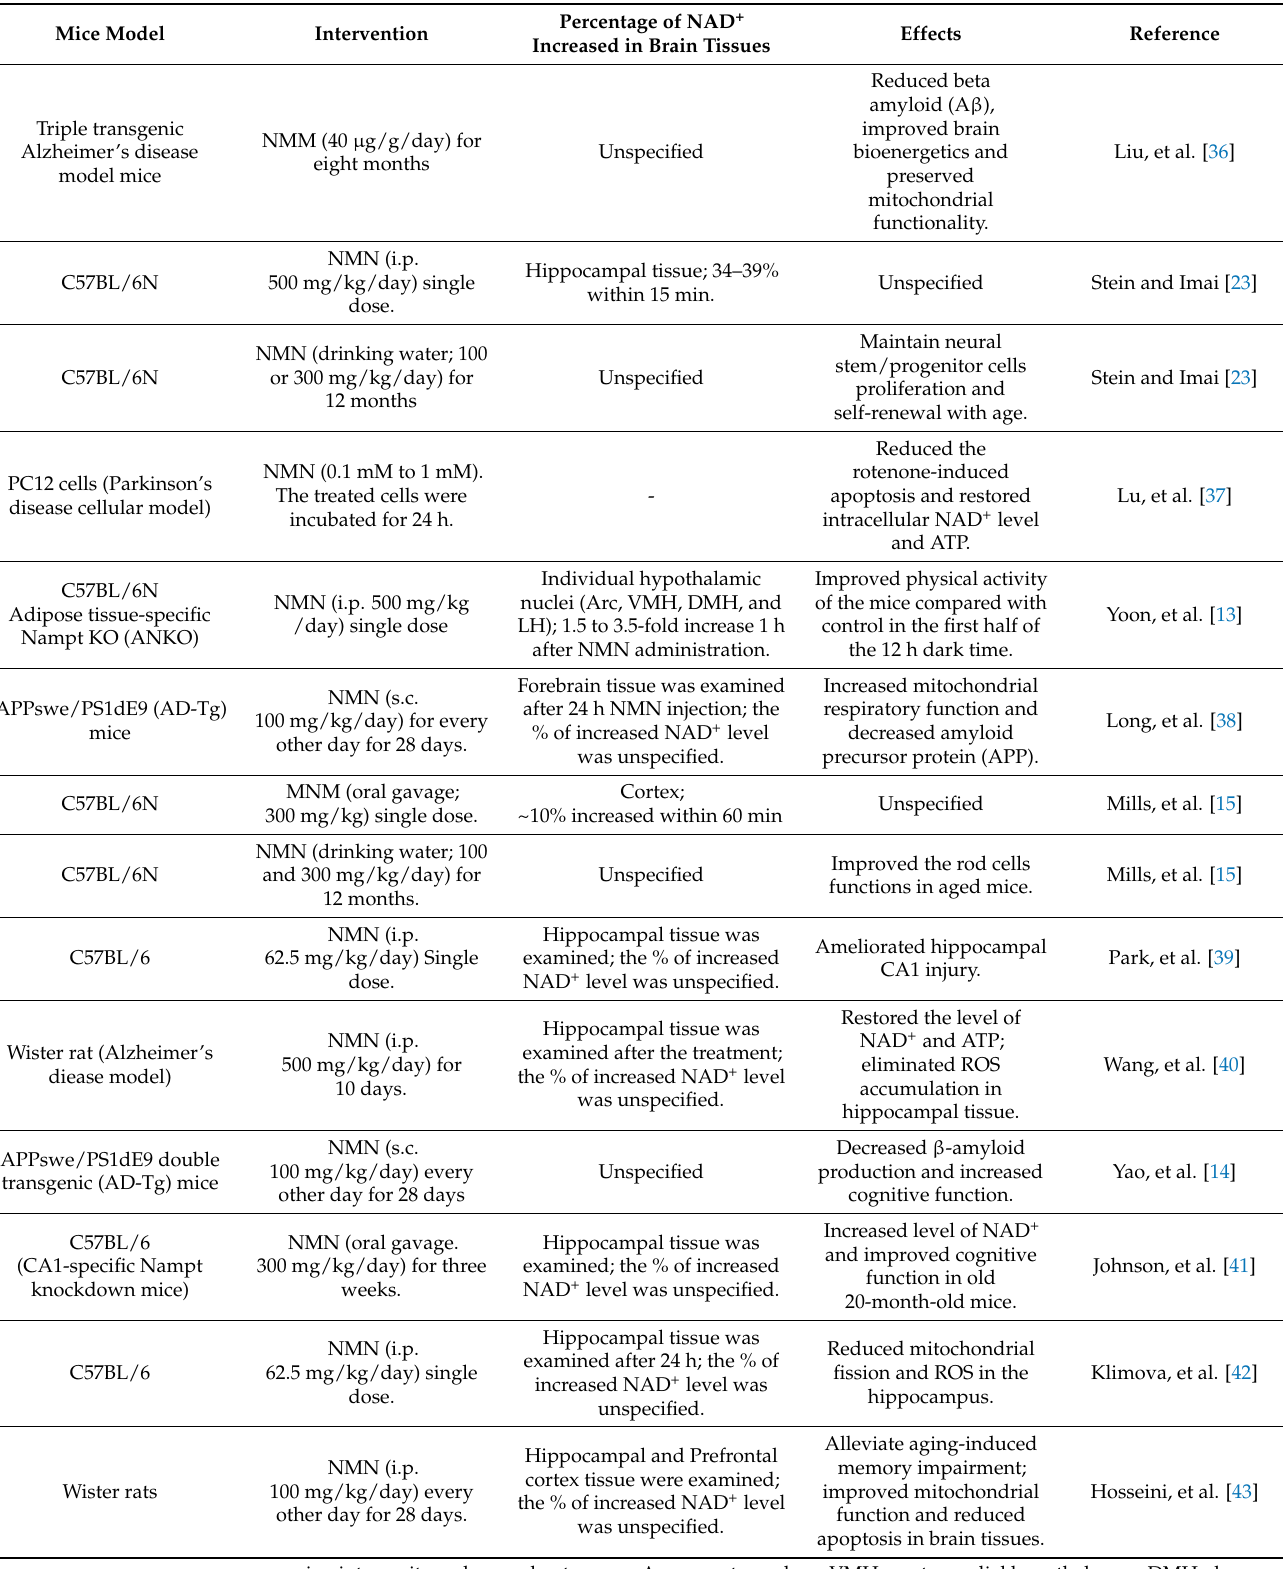
Table 1. Effects of NMN administration and level of NAD + in mice